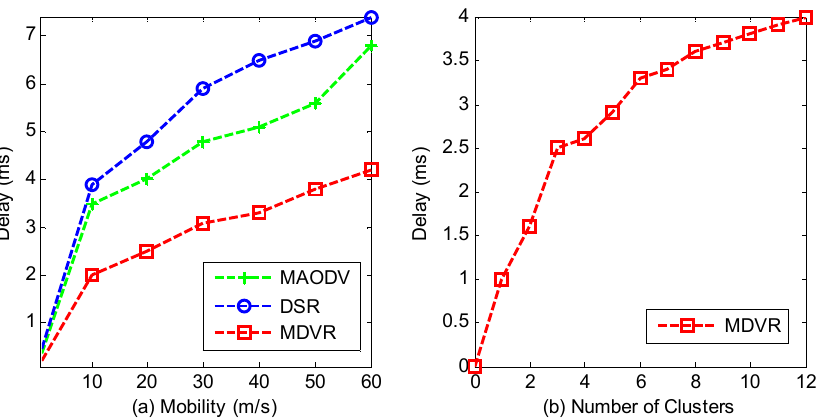
Figure 7. ( a ) UGAVs-MDVR delay with respect to mobility; ( b ) UGAVs-MDVR delay with respect to the number of clusters.